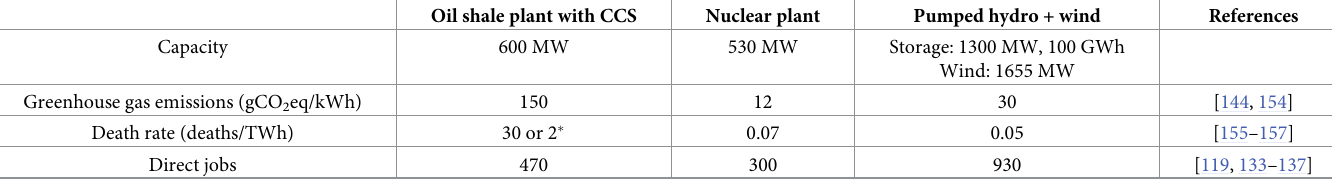
Table 2. Comparison of the environmental impact, safety, and job creation of low-emission electricity